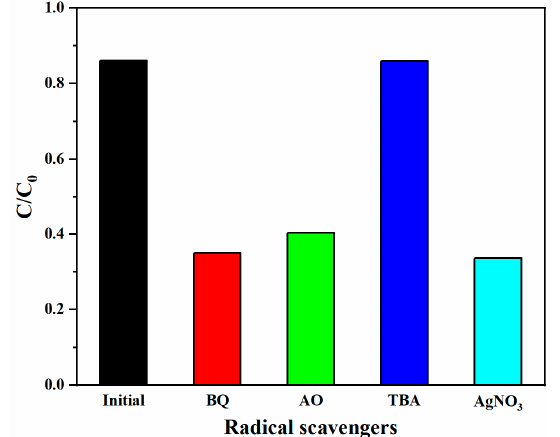
Figure 9. Photocatalytic degradation of MB by the ZnS/Ag 2 O composite alone and with different radical scavengers.